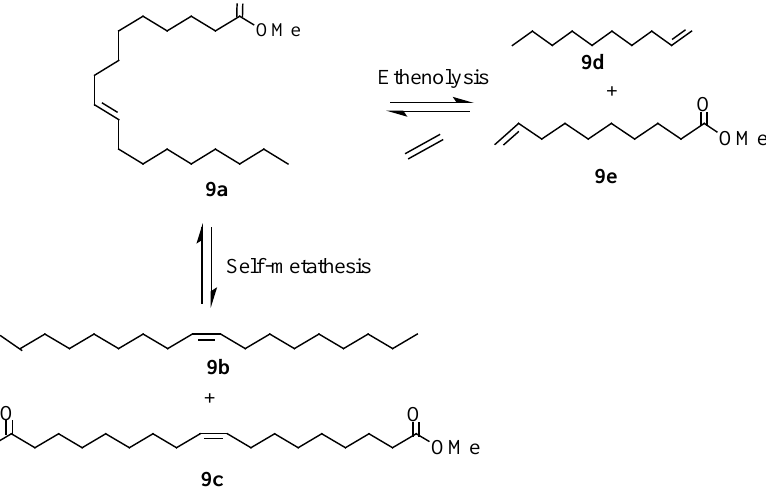
Scheme 4. Methyl oleate metathesis.